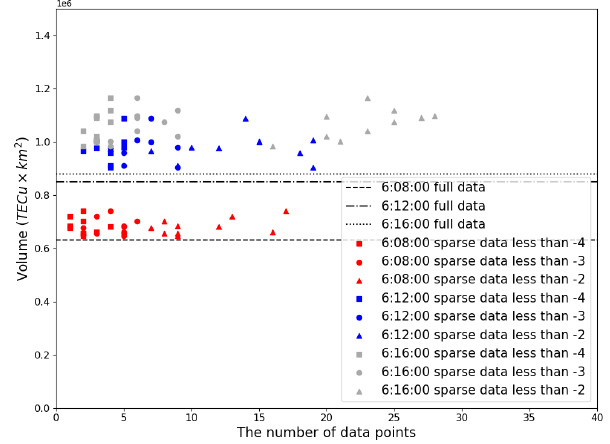
Figure 7. Comparison of the volume of the TIH calculated by sparse data (40 receivers) and the volume calculated using all data. Ran- dom choices are independently implemented 10 times. Points with square marks indicate the number of data points with a TEC value of − 4 or less and the computed volume of the TIH; round marks and triangular marks indicate those of − 3 or less and − 2 or less, re- spectively. The red color shows the data at 06:08:00. Also, blue and dark grey are at 06:12:00 and 06:16:00, respectively. The horizon- tal lines show the volumes calculated using all the data at 06:08:00, 06:12:00, and